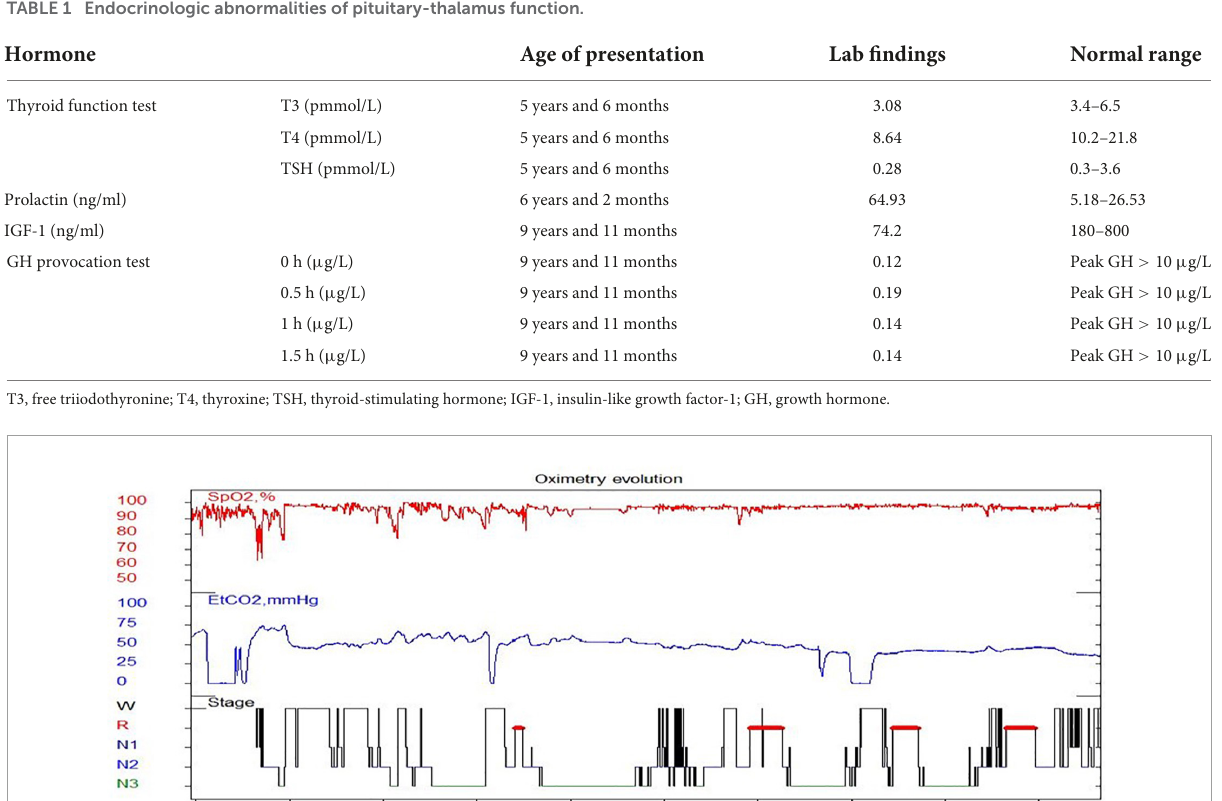
TABLE 1 Endocrinologic abnormalities of pituitary-thalamus function.